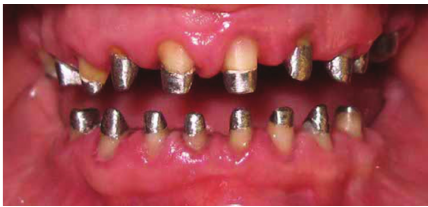
Figure 3: Prepared teeth before impression